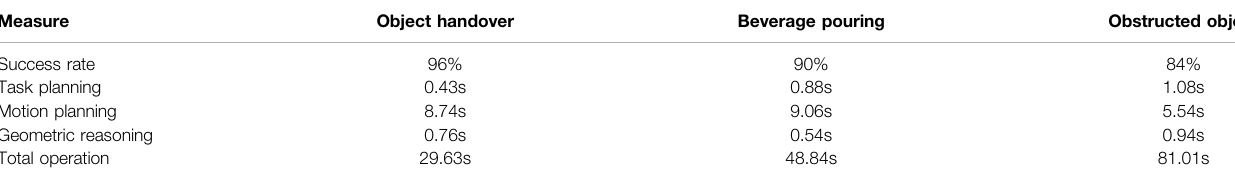
TABLE 1 | Results of each experiment in the V-REP simulation performed 50 times. Measure Object